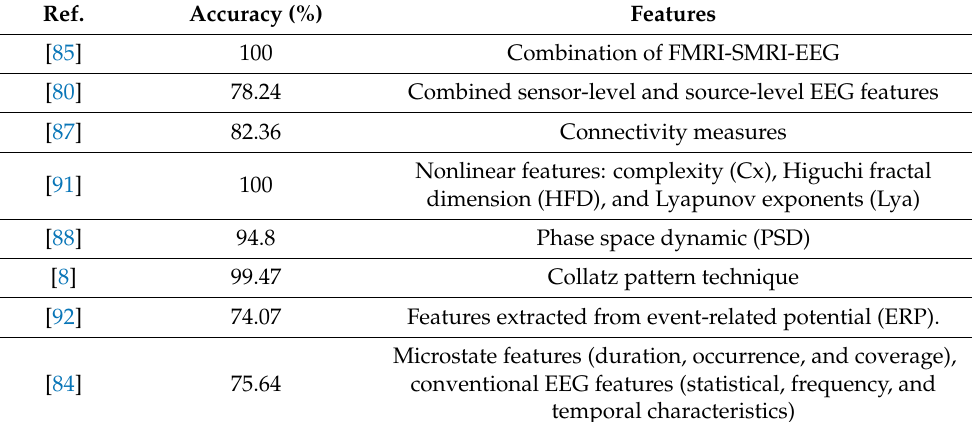
Table 4. References and accuracy obtained with EEG